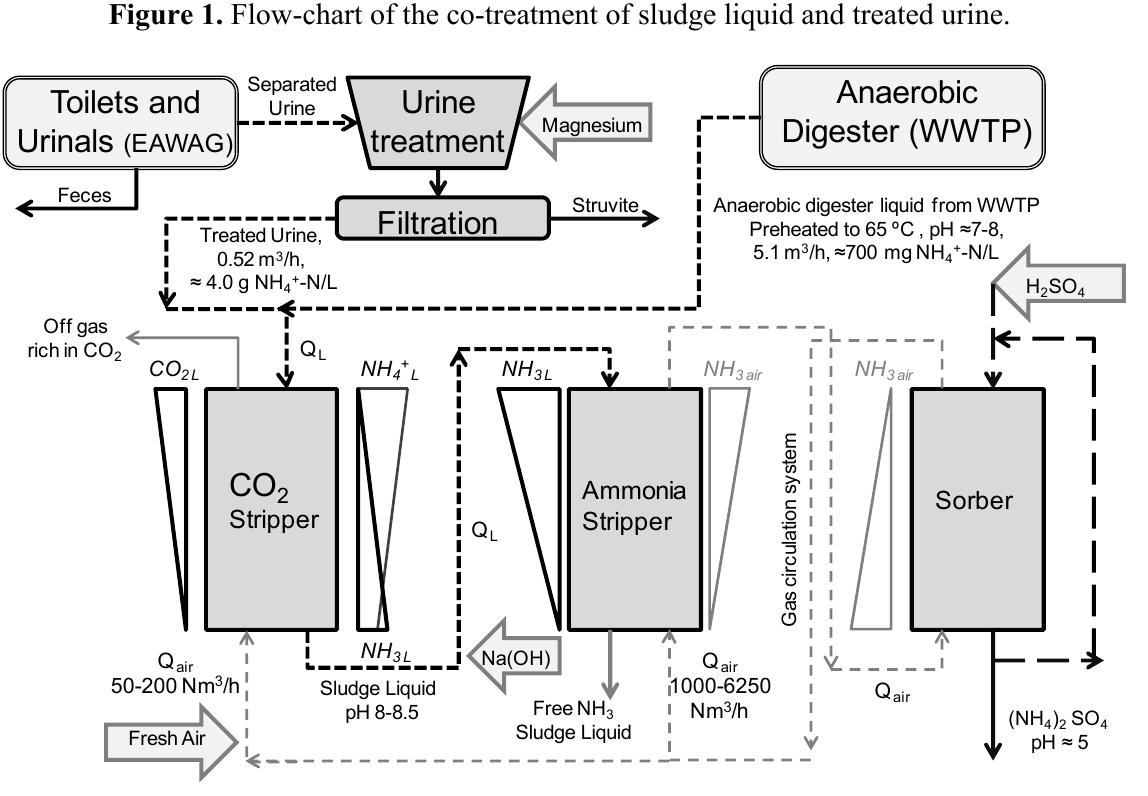
Figure 1. Flow-chart of the co-treatment of sludge liquid and treated